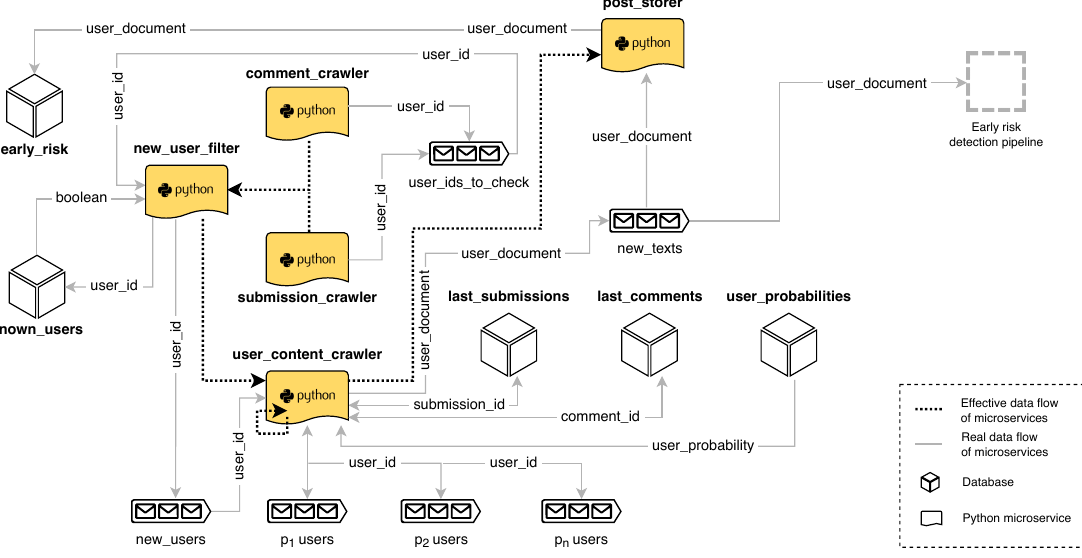
Figure 3. Diagram of the Social Media